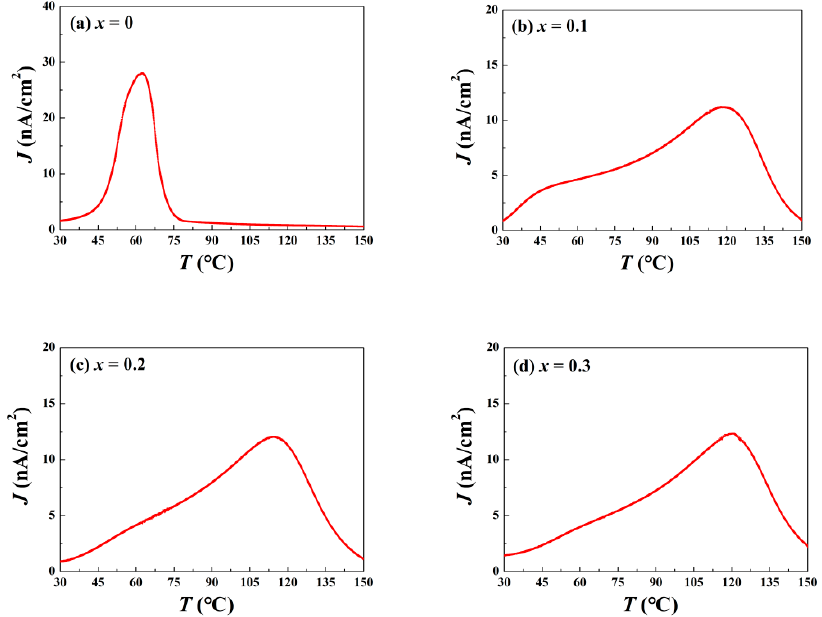
Figure 4. Temperature dependent thermal depolarization current density J for BNKT-BT- x ZnO composites: ( a ) x = 0, ( b ) x = 0.1, ( c ) x = 0.2, and ( d ) x = 0.3.